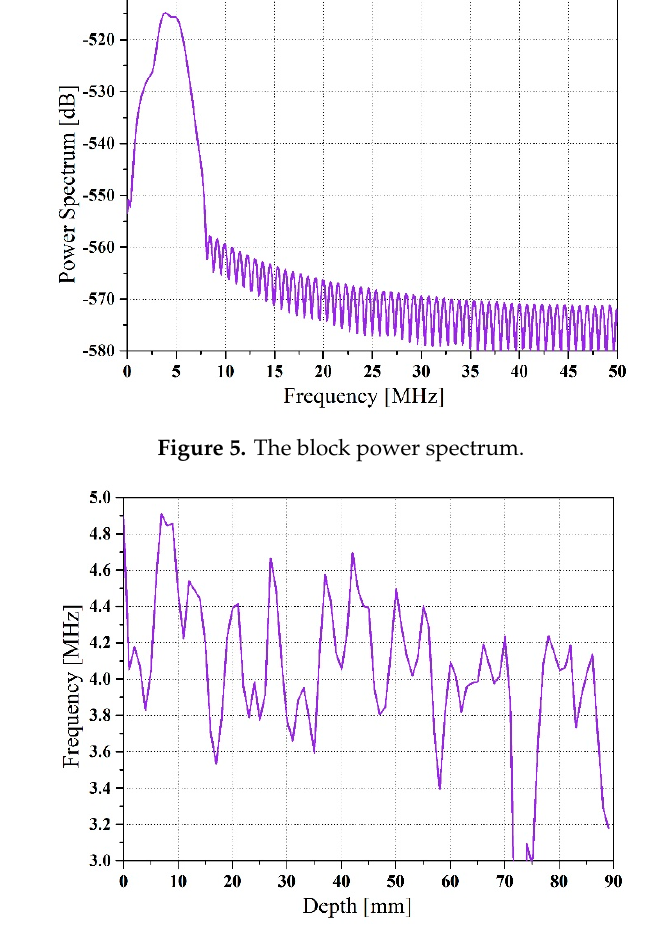
Figure 6. The spectral shift.